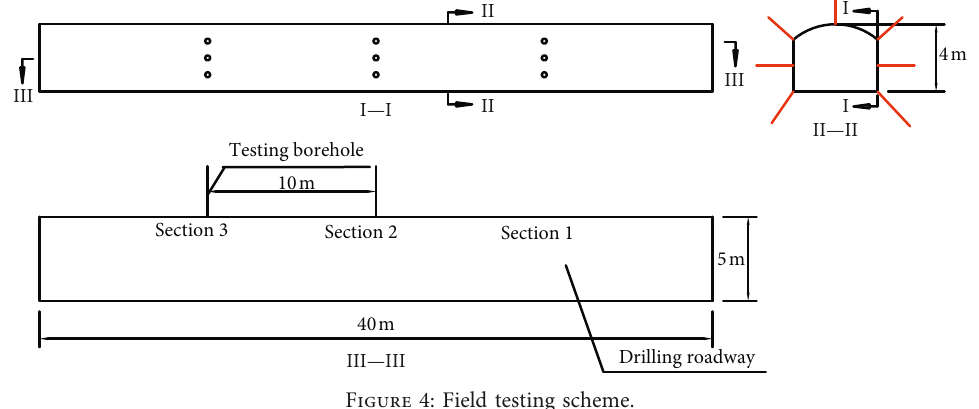
Figure 4: Field testing